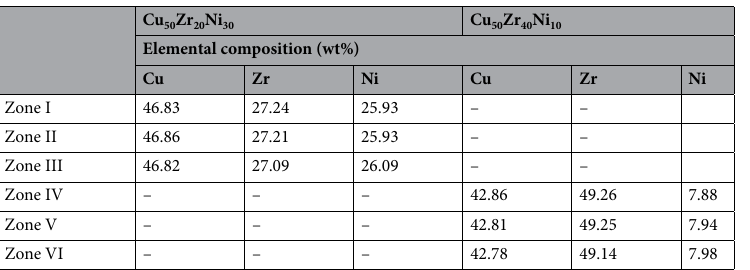
Table 2. Elemental analysis conducted by FE-SEM in conjunction with EDS for as prepared Cu 50 Zr 20 Ni 30 , and